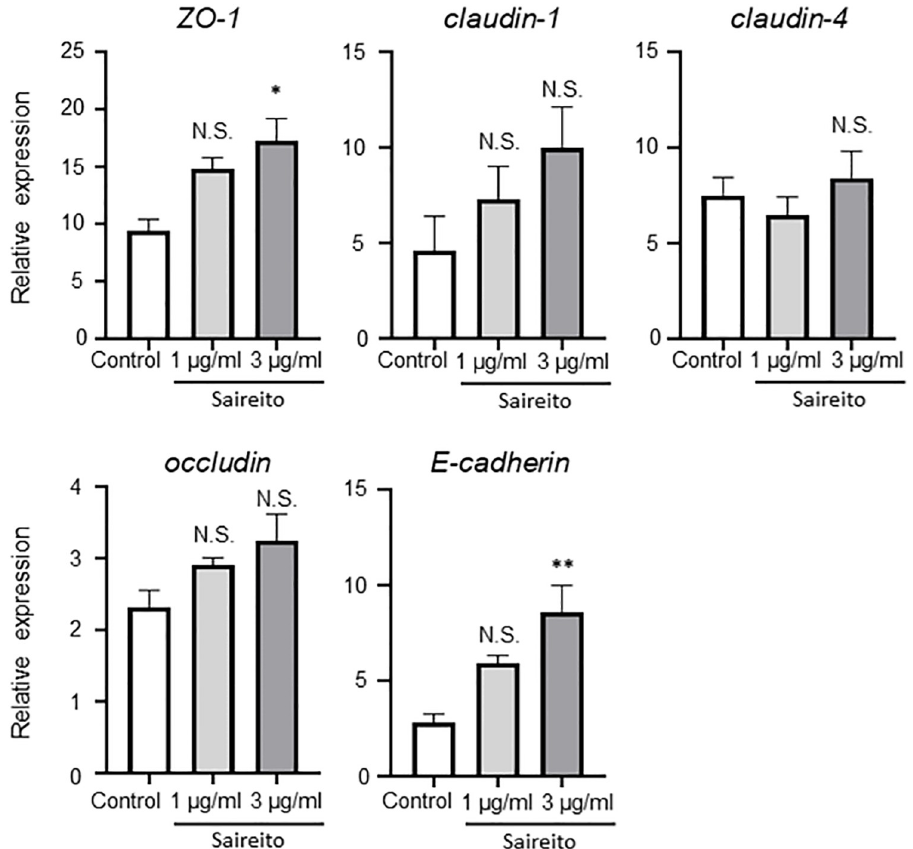
Fig 5. Effect of Saireito co-treatment on the induction of cell adhesion protein in vitro. (A) mRNA analysis of cell adhesion proteins in vitro . The concentrations of Saireito were 1 μ g/ml or 3 μ g/ml. Statistical analysis was carried out using Dunnett’s test. Data are shown as mean ± SEM (n = 3, each group). � P < 0.05, �� P < 0.01 vs Control.